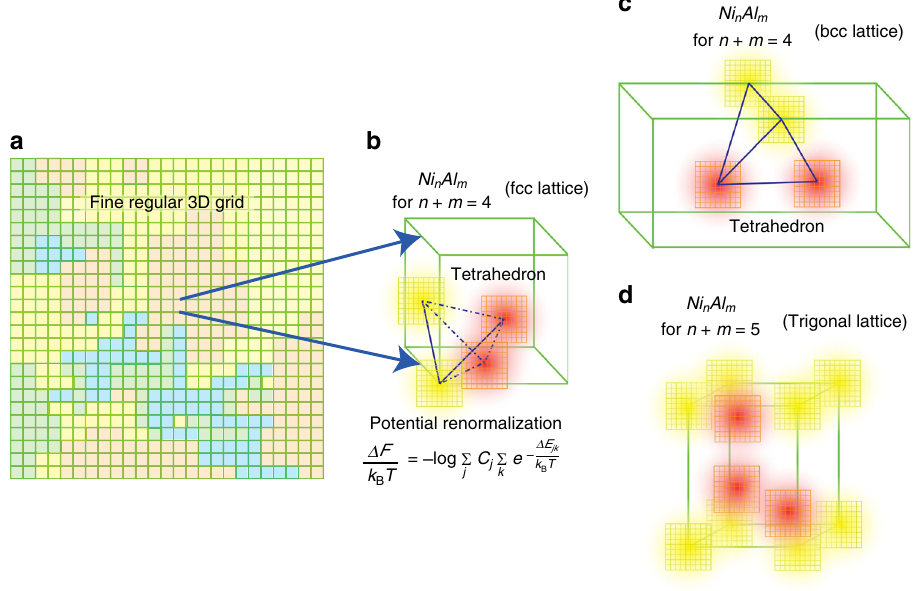
Fig. 1 Pictorial representation of cluster expansion and potential renormalization theory. a The real space is divided into a fi ne regular 3D grid. One grid cube represents one unit cell and different colors represent different alloy composition within the unit cell. One unit cell of the Ni – Al alloy containing a tetrahedron formed by four nearest neighbor atomic positions for b fcc lattice, c bcc lattice. d Unit cell of trigonal structure. These atomic positions are occupied by n Ni atoms (yellow) and m Al atoms (orange) representing the composition Ni n Al m , in the cluster expansion theory. The 3D grids around each of the atoms are the points, where the atom was displaced during potential renormalization calculation